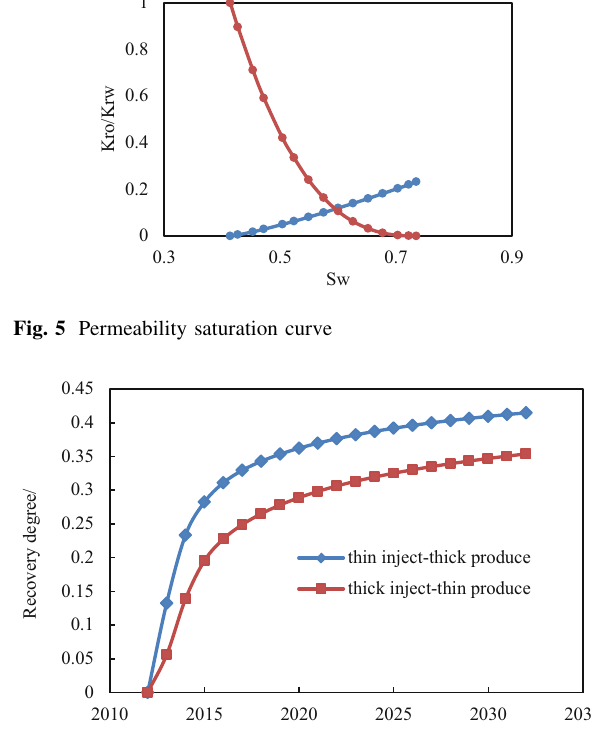
Fig. 6 Recovery degree of different injection/production types in heterogeneous 2D